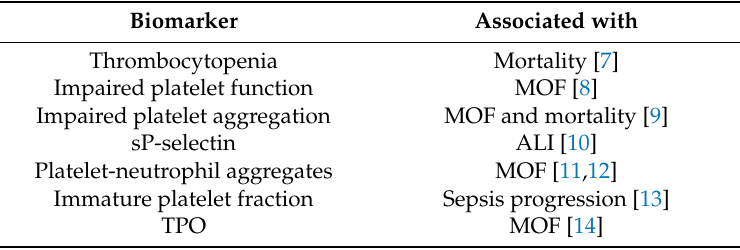
Table 1. Platelet-related biomarkers of sepsis severity in human studies. MOF, multi-organ failure; ALI, acute lung injury; TPO, thrombopoietin. Modified from